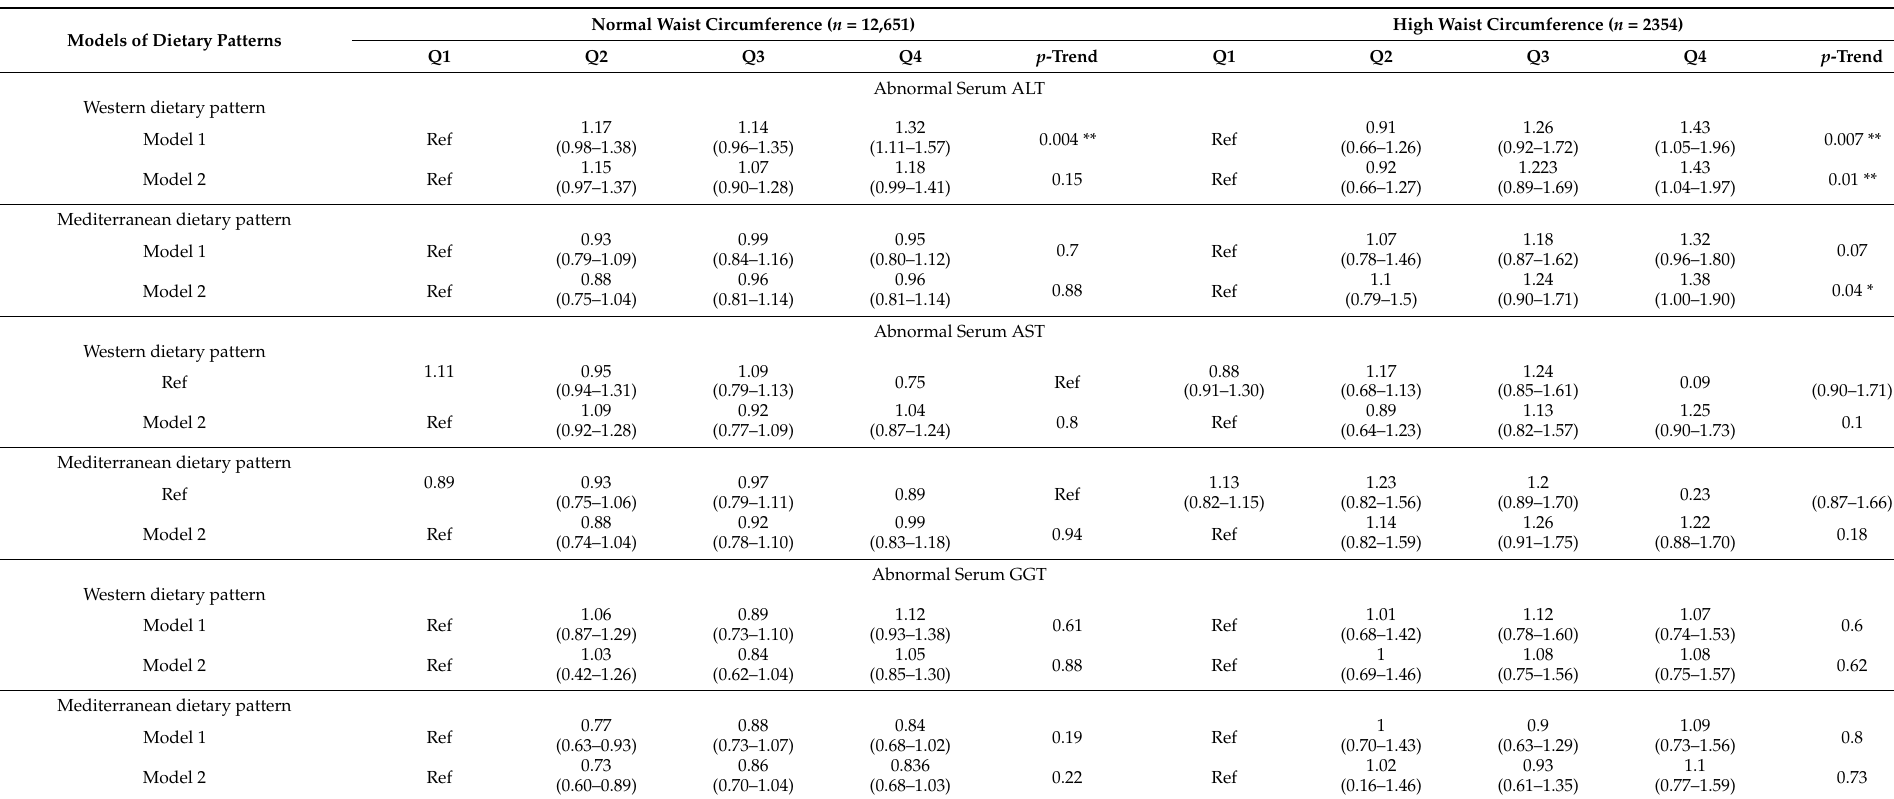
Table 6. Odds ratios for abnormal serum hepatic enzyme levels across quartiles of major dietary patterns stratified by waist circumference ( n = 15,005) 1 . Models of Dietary